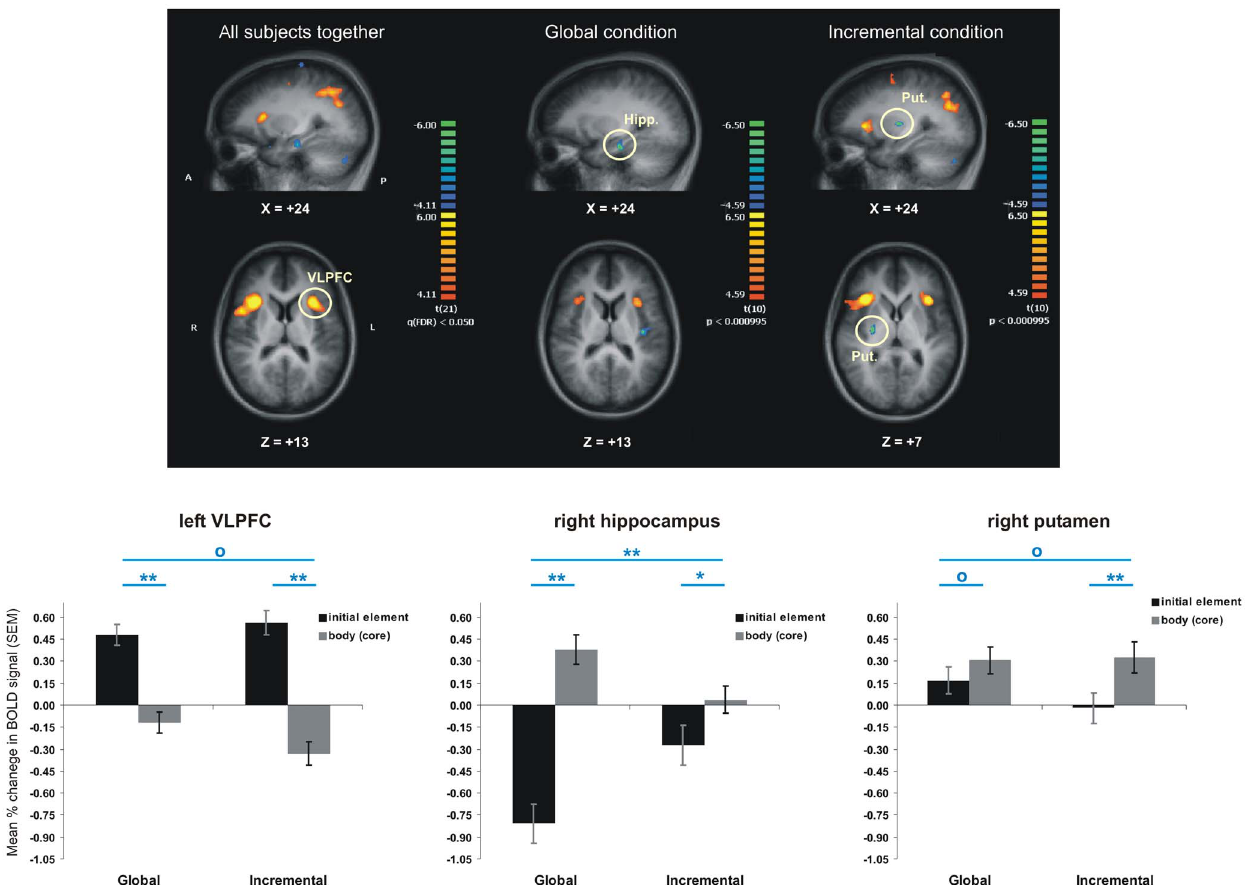
Figure 5. Areas more activated during initial than the subsequent elements of a sequential chunk (orange regions), as well as areas activated more during the core than initial chunk element (blue regions). The bar graphs show the percentage change in blood oxygenation level dependent (BOLD) signal in selected regions, for each group and type of trials. Blue stars indicate significant statistical differences (p , 0.05 for one star and p , 0.001 for two stars), whereas blue circles indicate no significant difference.